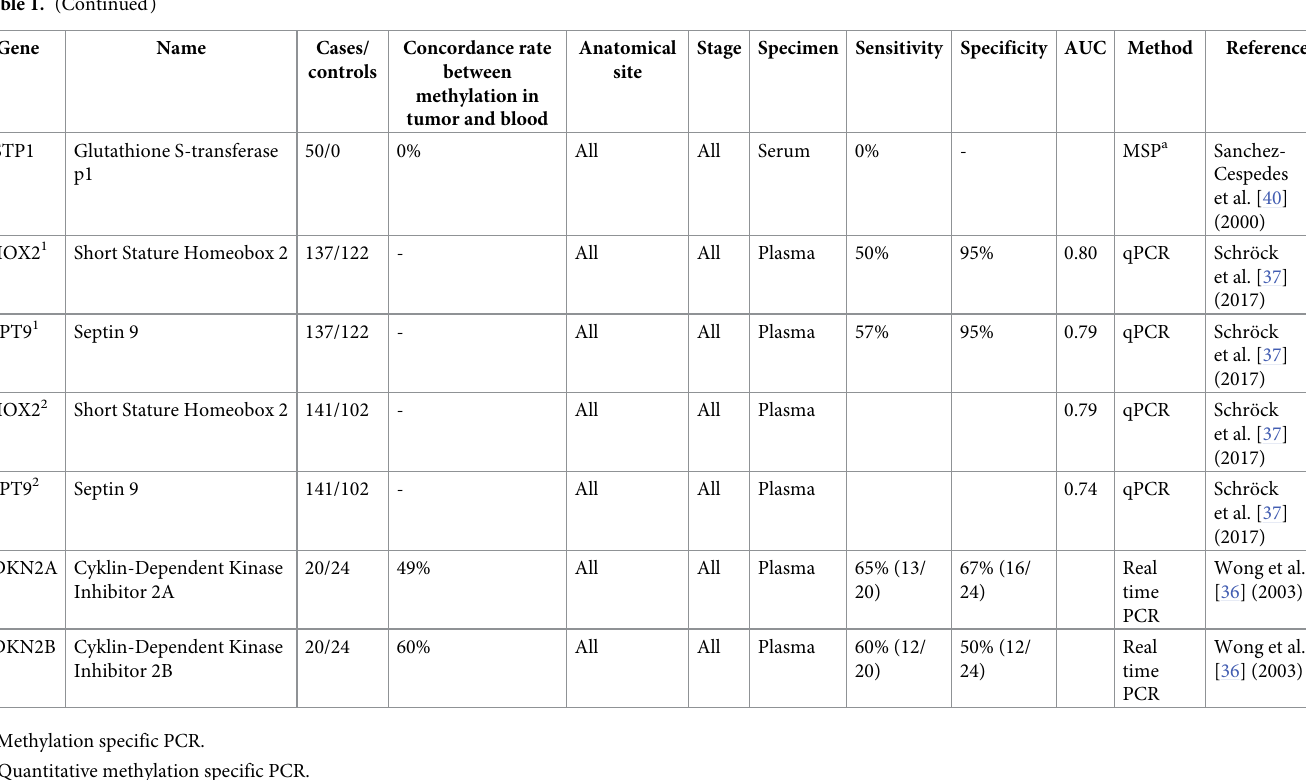
patients, had aberrant methylation in the peripheral blood. In addition, all three had aberrant methylation in both tumor and serum prior to treatment. Using MSP for either methylated or unmethylated sequences, Sanchez-Cespedes et al. [40] published a study in 2000 examining aberrant methylation of four genes, CDKN2A,